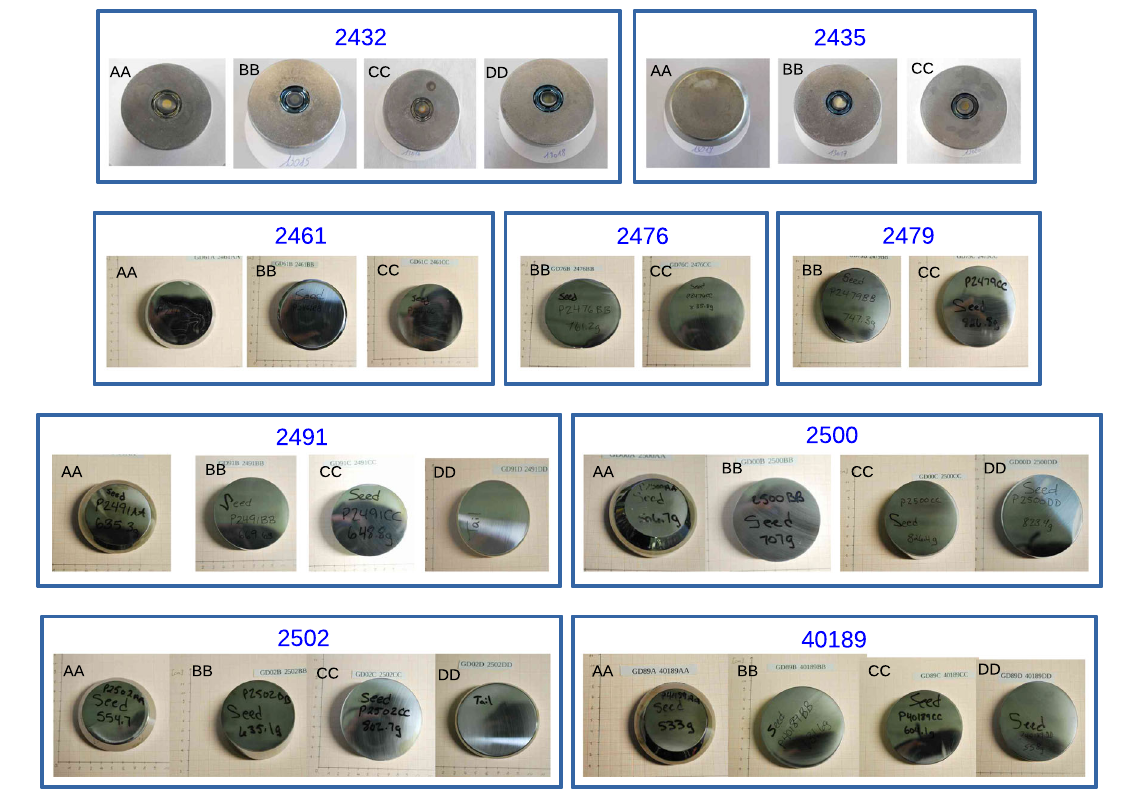
belonging to the 1st batch are depicted in their final diode form (row 1), while the other 7 series from the 2nd batch are shown as crystal slices prior to diode conversion (rows 2–4)